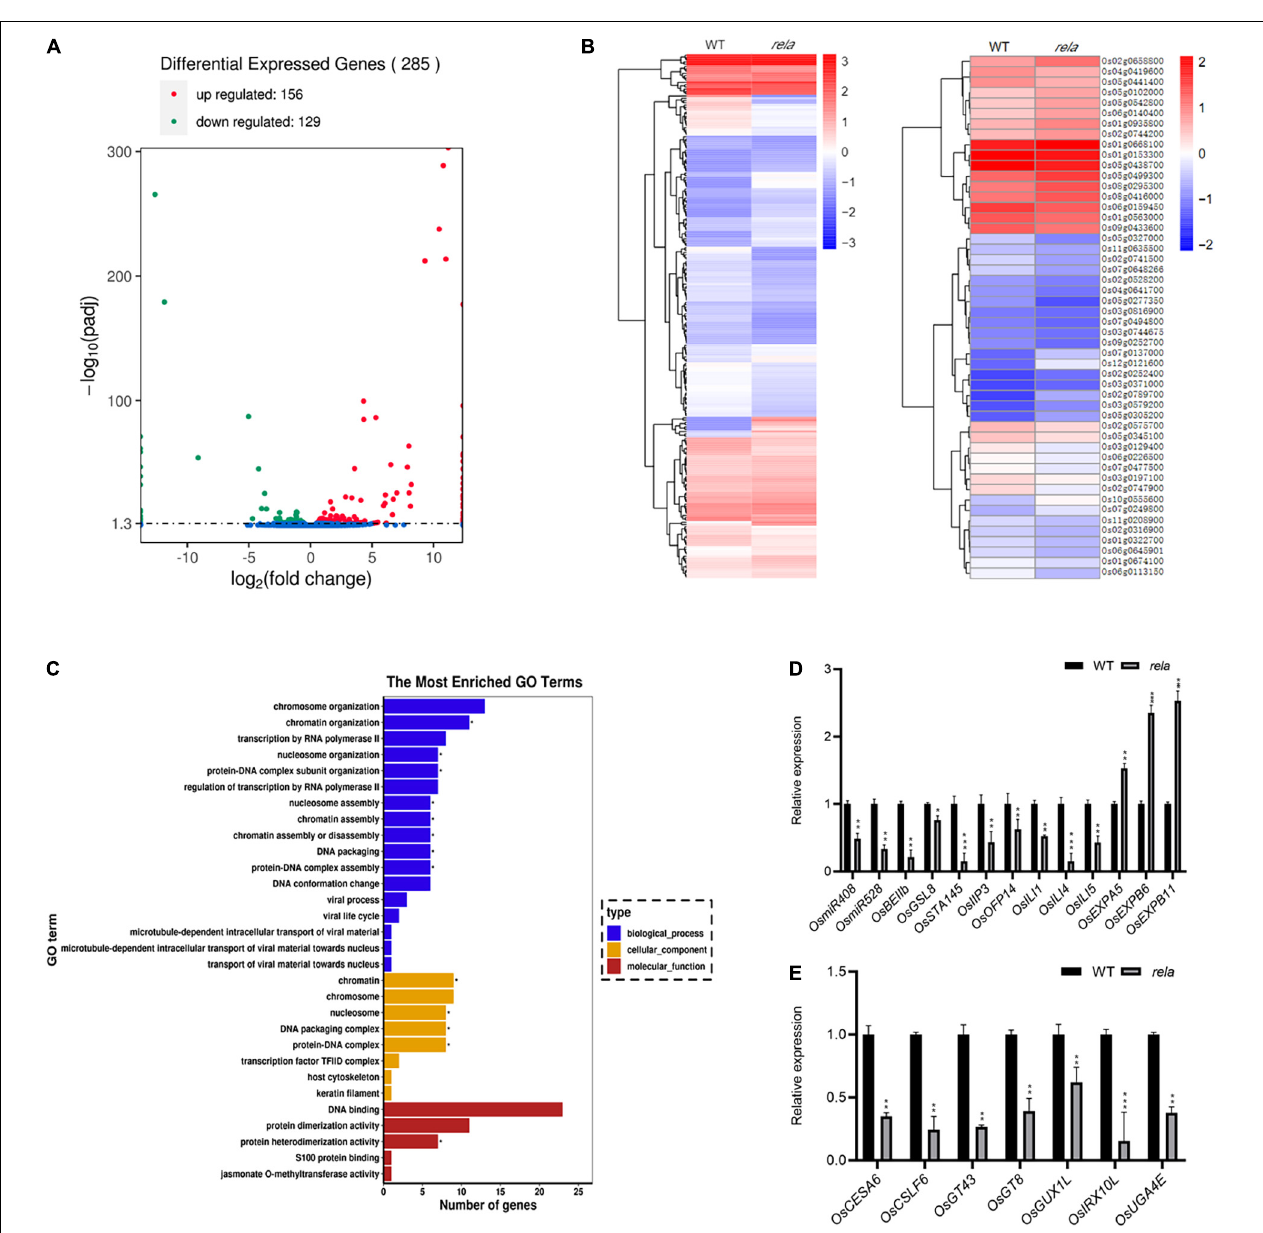
FIGURE 4 | RNA-seq analysis of OsRELA -modulated genes. (A) A volcano plot illustrating differentially expressed genes from RNA-seq analysis between wild-type and rela . Genes upregulated and downregulated are shown in red and green, respectively. Values are presented as the log2 of tag counts. (B) Heat map of the RNA-seq analysis results shows all genes that were significantly differentially expressed (left panel) and the representative top 50 genes that were differentially expressed (right panel). (C) Gene ontology (GO) functional clustering of all genes that were differentially expressed. (D) RT–qPCR validation analysis of the gene expression levels between wild-type and rela revealed by RNA-seq. The rice UBQ gene was amplified as the internal control. Asterisks indicate significant differences from the WT (* P < 0.05, ** P < 0.01, *** P < 0.001, Student’s t -test). (E) RT–qPCR analysis of the genes involved in cell wall synthesis. The rice UBQ gene was amplified as the internal control. Asterisks indicate significant differences from the WT (** P < 0.01, *** P < 0.001, Student’s t